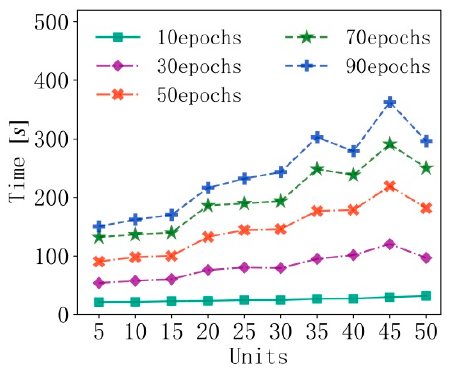
Figure 13. Diagram of the variation trend of fitting time with epochs and units.